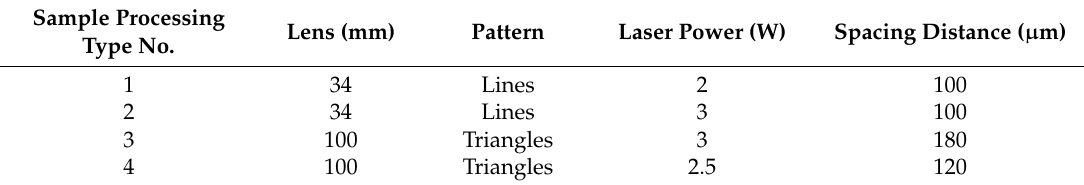
Table 1. Laser processing parameters.